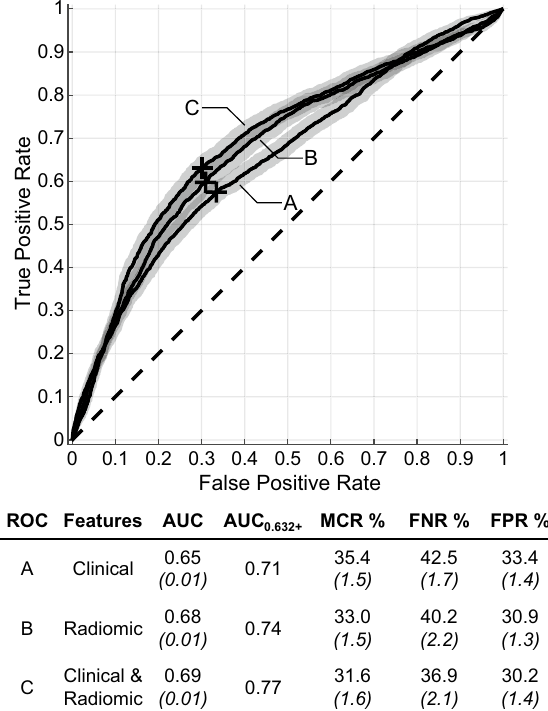
Figure 1. Comparison of average ROC curves across bootstrapped repetitions when clinical, radiomic, or clinical and radiomic features were used. The AUC for each curve is provided, along with the corrected AUC 0.632+ value. The optimal upper-left operating point determined from the out-of-bag dataset is plotted as “+”, for which the MCR, FNR, and FPR were found. A false negative represents a BM that was predicted to respond to SRS, but instead progressed after SRS. 95% confidence intervals are provided for the curves (shaded bands) and error metrics (in parentheses).